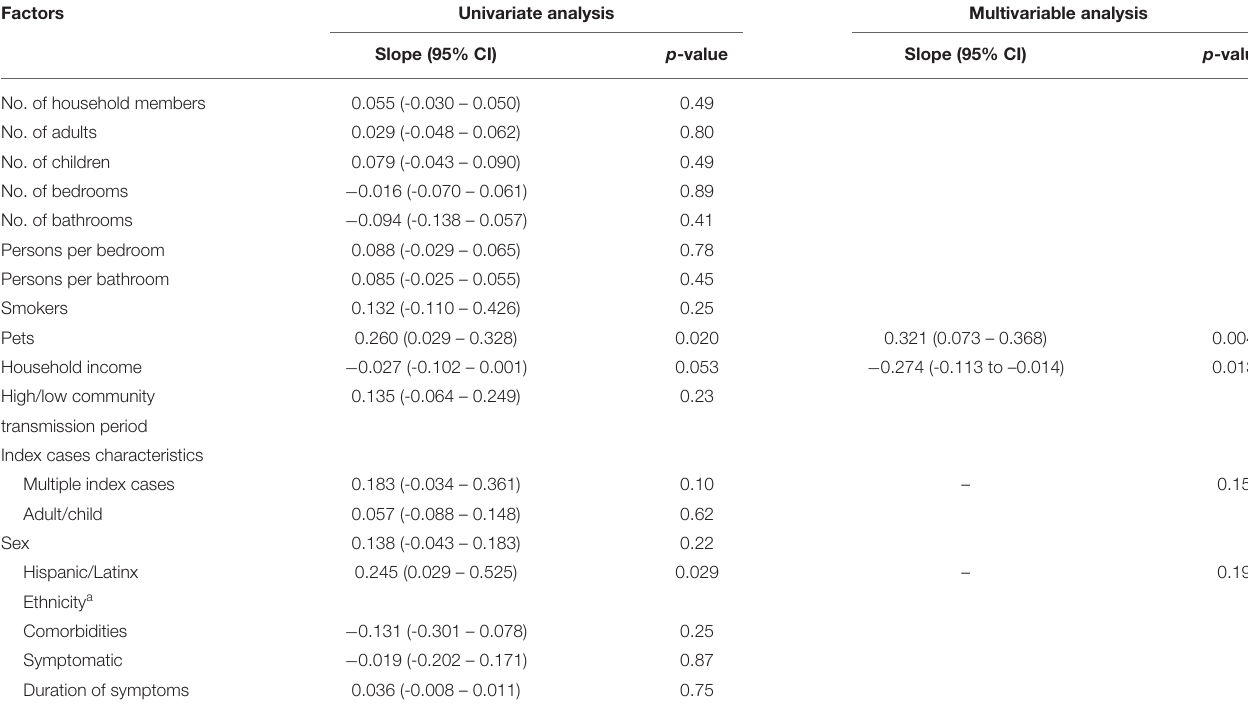
TABLE 3 | Univariate and multivariable linear regression analysis of predictors of the household secondary attack rate (SAR).